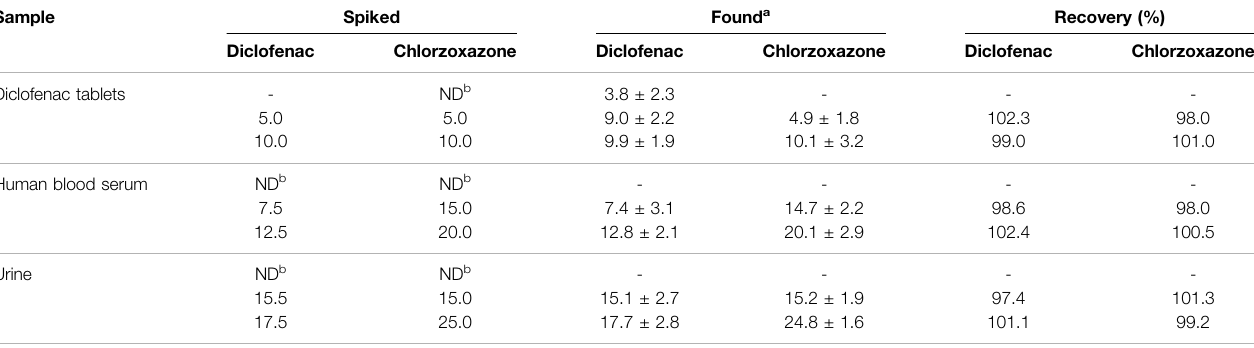
TABLE 1 | Application of La 2 O 3 @SF-L Cu 2 S/GCE for concurrent determination of diclofenac and chlorzoxazone in diclofenac tablets, human blood serum, and urine samples. All concentrations are in µM. Sample